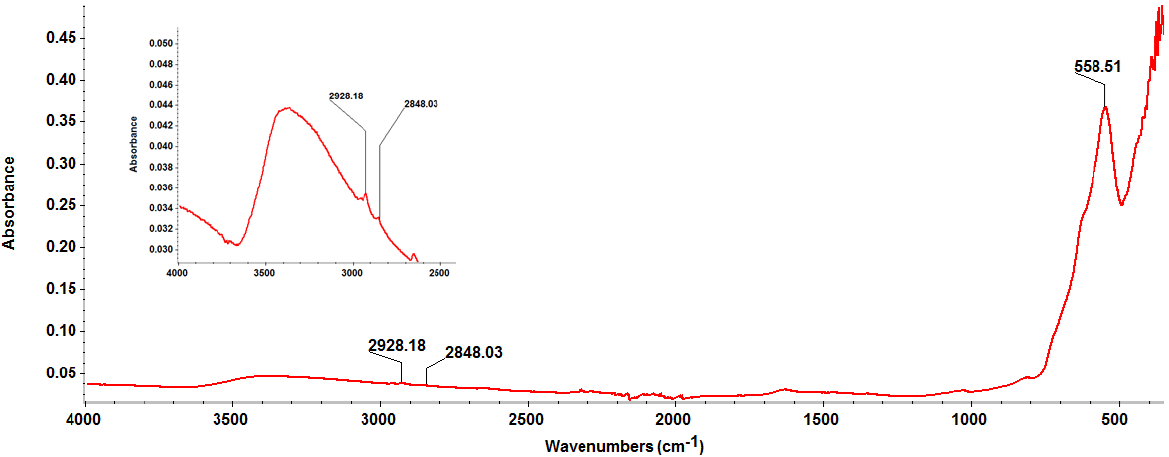
Figure 2. Fourier transform infrared spectroscopy (FT-IR) spectrum of Fe 3 O 4 @EG particles.